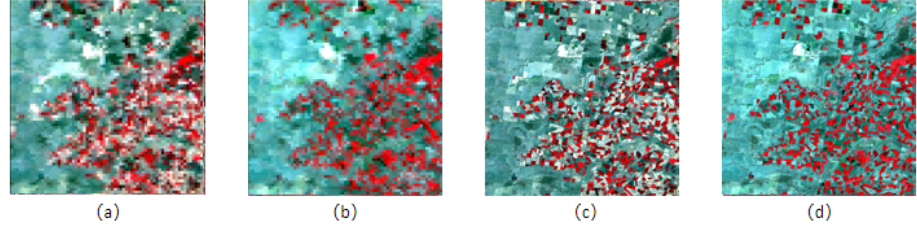
Figure 11. Test data from the CIA dataset. These figures exhibit the false color composite images using band 4, band 3, and band 2. ( a , c ) are the MOIDS and Landsat images on 11 January 2002, respectively. ( b , d ) are the MOIDS and Landsat images on 12 February 2002,